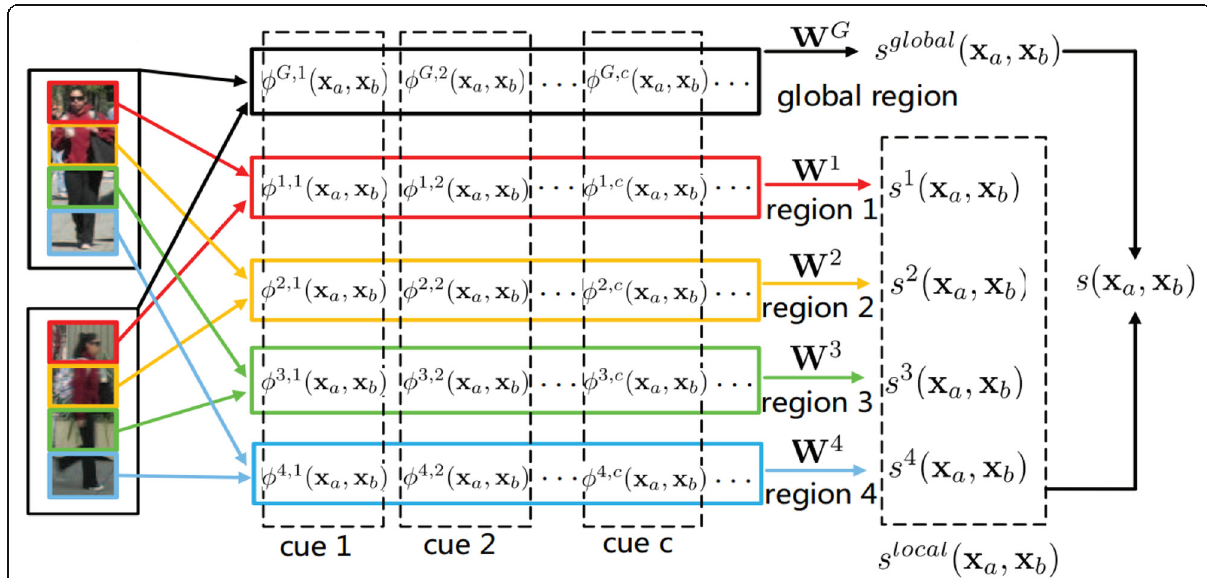
Fig. 12 Illustration of the similarity learning using spatial constraints based on polynomial-kernel feature map [50]